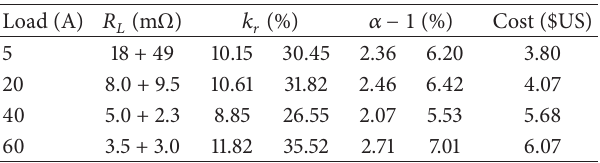
Figure 6: Improvement efficiency factor. Table 1: Resistance relation and improvement efficiency factor with commercial elements.